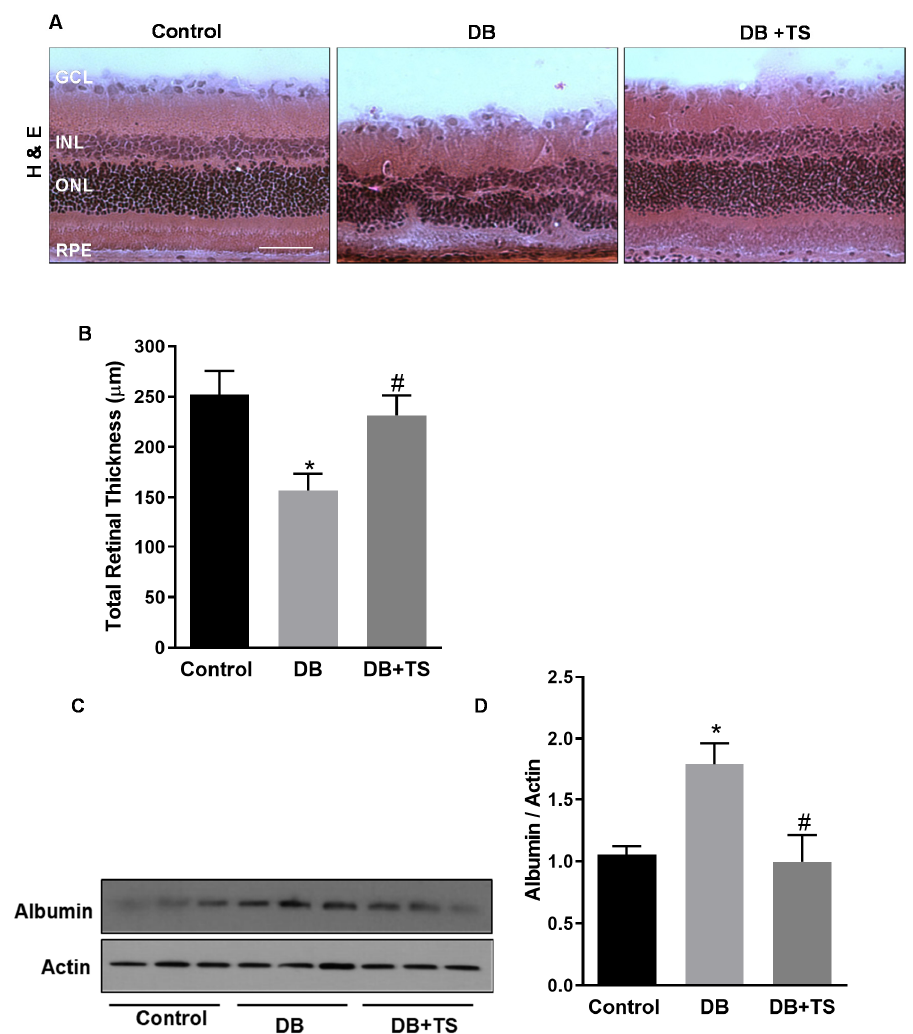
Figure 3. E ff ects of Tubastatin A on retinal histopathology and vascular leakage. ( A ) Hematoxylin and eosin (H&E) staining of retinal cryosections assessing retinal morphology of STZ-rats (DB), STZ-rats receiving TS (10 mg / kg) (DB + TS) and normoglycemic control rats (control). Scale bar, 50 µ m. ( B ) The bars represent retinal thickness values measured in H&E retinal cryosections obtained from the di ff erent treatment groups. ( C ) Western analysis of albumin extravasation in retinas of diabetic STZ-rats (DB), STZ-rats receiving 10 mg / kg TS (DB + TS) and normoglycemic control rats (control). ( D ) Bar histograms representing optical density of albumin normalized to actin. Values are mean ± SEM for n = 6. * p < 0.05 vs. control and # p < 0.05 vs.